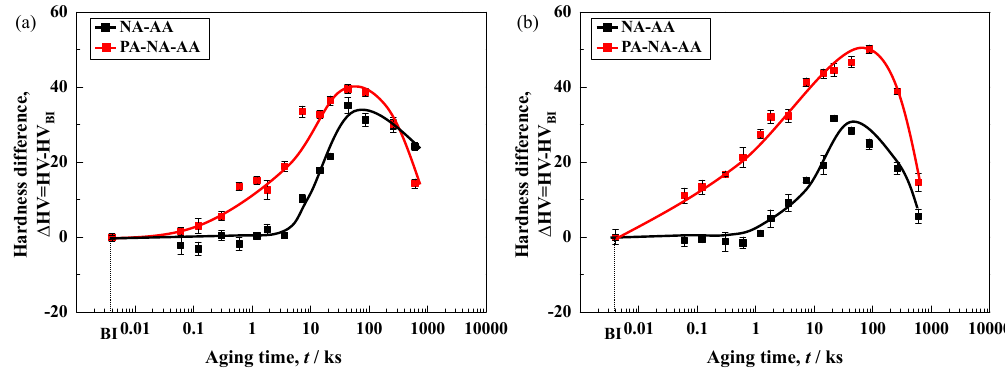
Figure 3. Hardness during aging at 170 °C with the different heat treatments in ( a ) 3M10S and ( b ) 9M10S. AQ, PA, NA and AA stand for as-quenched, pre-aging at 100 °C for 3600 s, natural aging at room temperature for 7 days, and artificial aging at 170 °C, respectively.